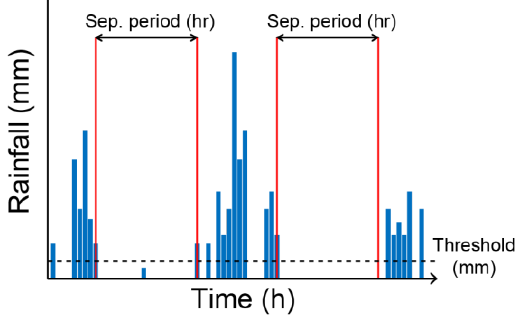
Figure 16. Events separation criteria implemented in the automatic procedure for the detection rainfall events. The procedure main parameters are the separation period (in hours) and the rainfall threshold values (in mm).